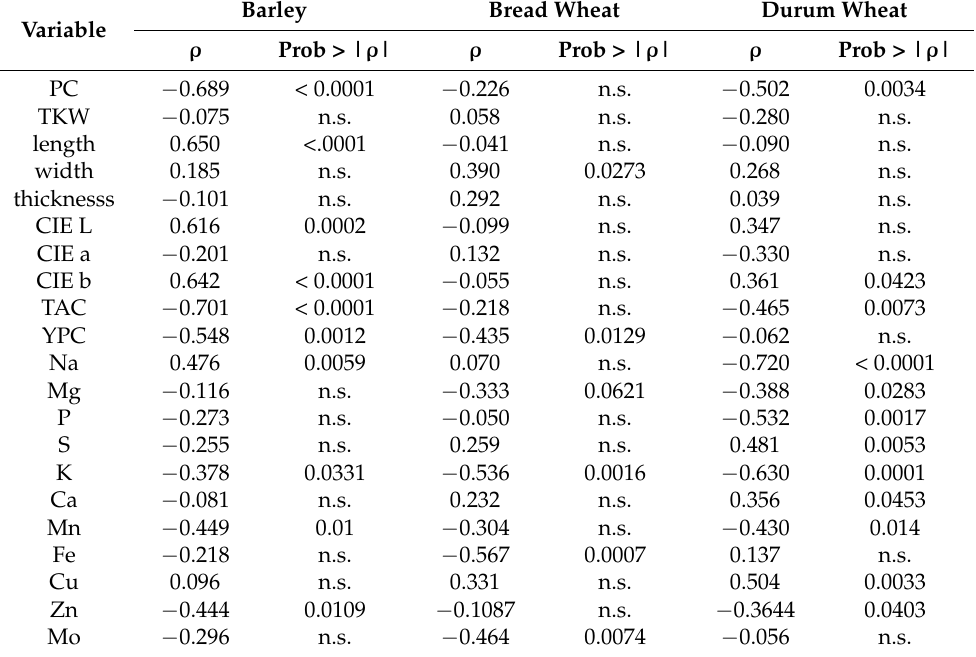
Table 5. Variables with significant Spearman correlation to grain yield (GY) in the three species. P = Spearman’s rank correlation coefficient; Prob = probability approximated to t-distribution; n.s. = not